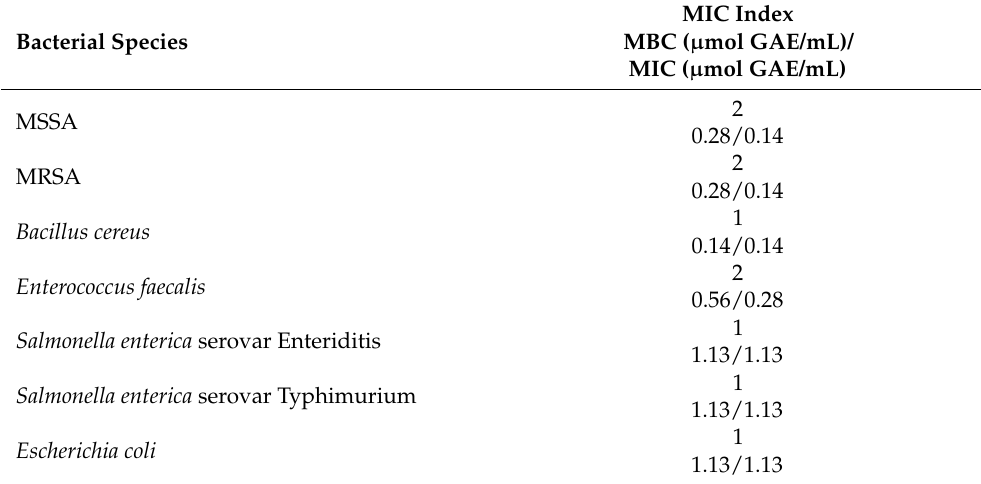
Table 5. In vitro antibacterial activity of L-R (broth microdilution assay).